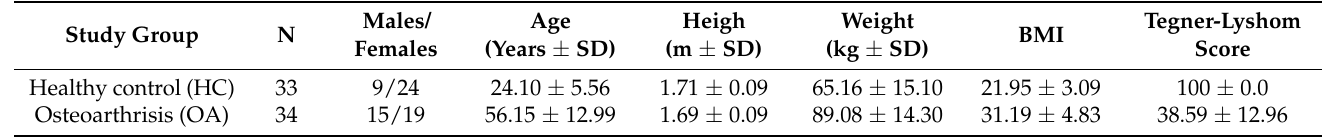
Table 1. Characteristics of study